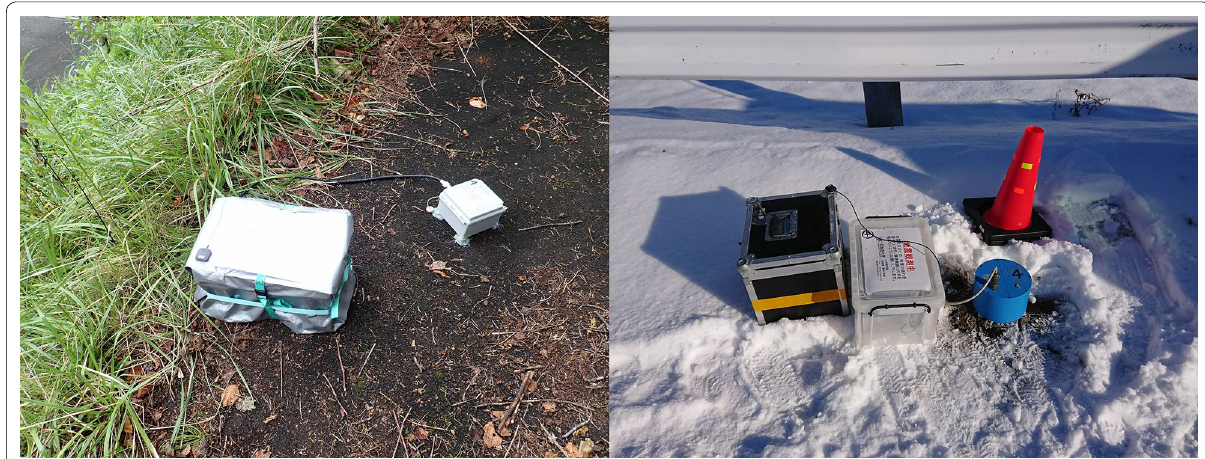
Fig. 6 Photographs of the setting situation. The temporally strong motion station (left: MKW01). The microtremor observation